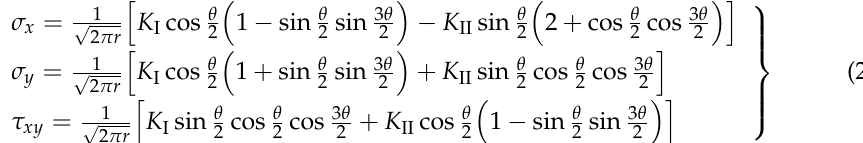
Figure 2. Stress model of rock mass after fissure water freezing.